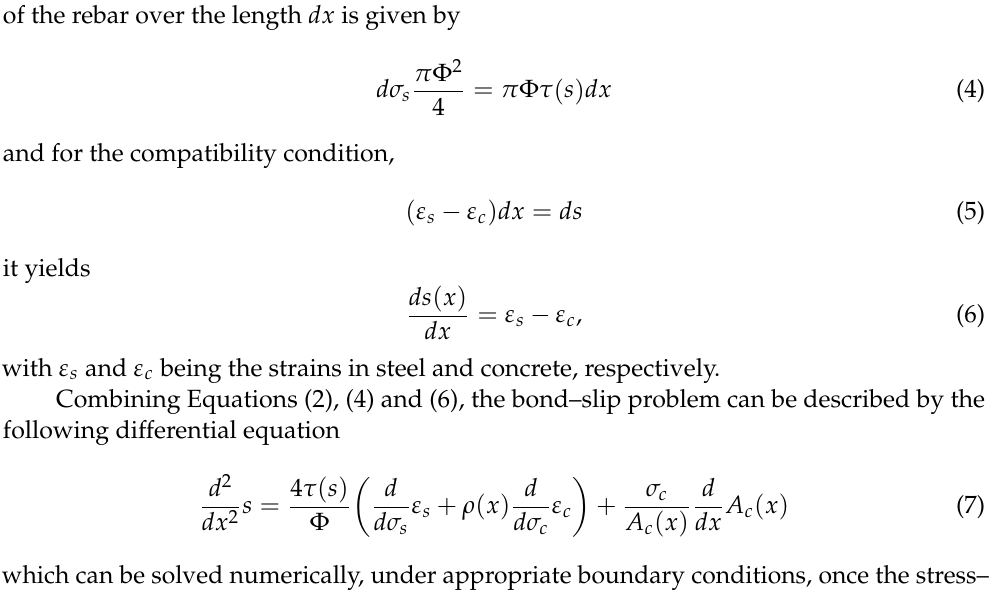
Figure 1. Stresses and elongations on an infinitesimal r.c. tie.